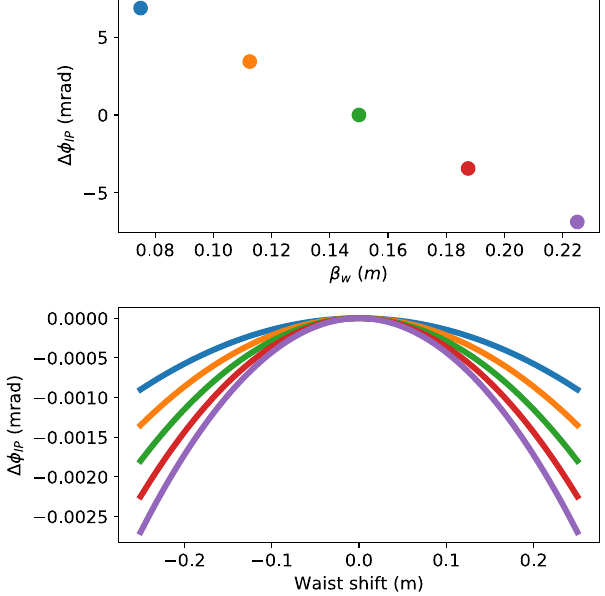
FIG. 10. Behaviour of the phase-advance change across the IP optics drift with changing β w (top) and changing waist shift (bottom). As the change with waist shift depends significantly on the β w the phase deviation with changing waist shift is shown for the different β w in the upper plot, with corresponding colors.